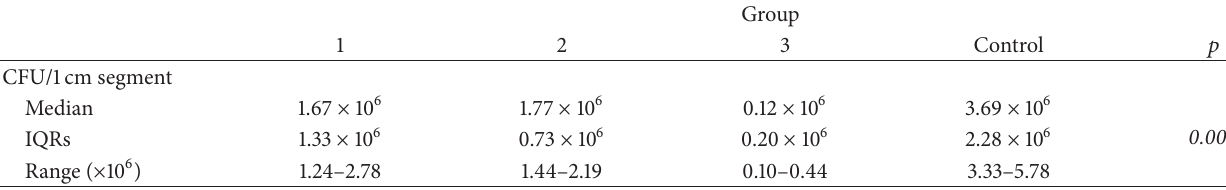
Table 2: Quantification of the sessile bacteria on catheter surface at the end of the experiment.